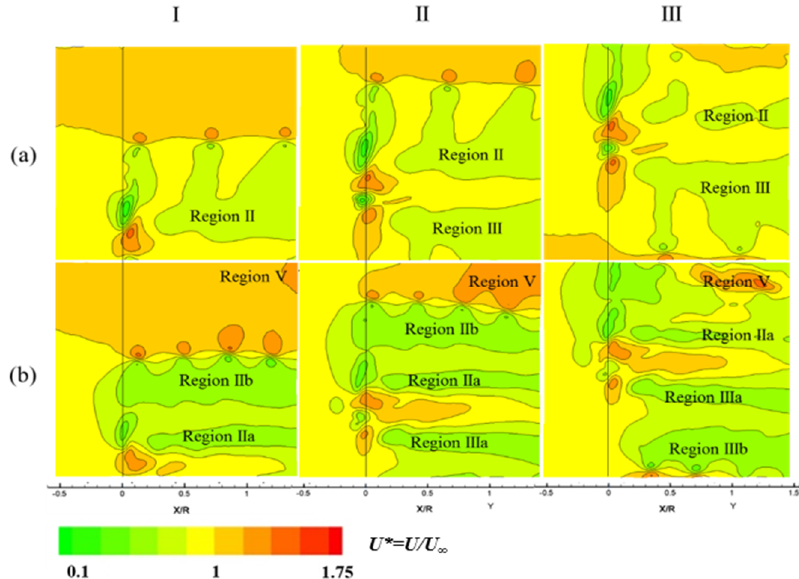
Figure 13. Contour plot of normalized stream-wise velocity ( U * = U / U ∞ ) for δ h U of 0.55 (column I ), 0.27 (column II ), and 0.05 (column III ) at different rotational velocities (180 RPM, row a ; 270 rpm, row b )